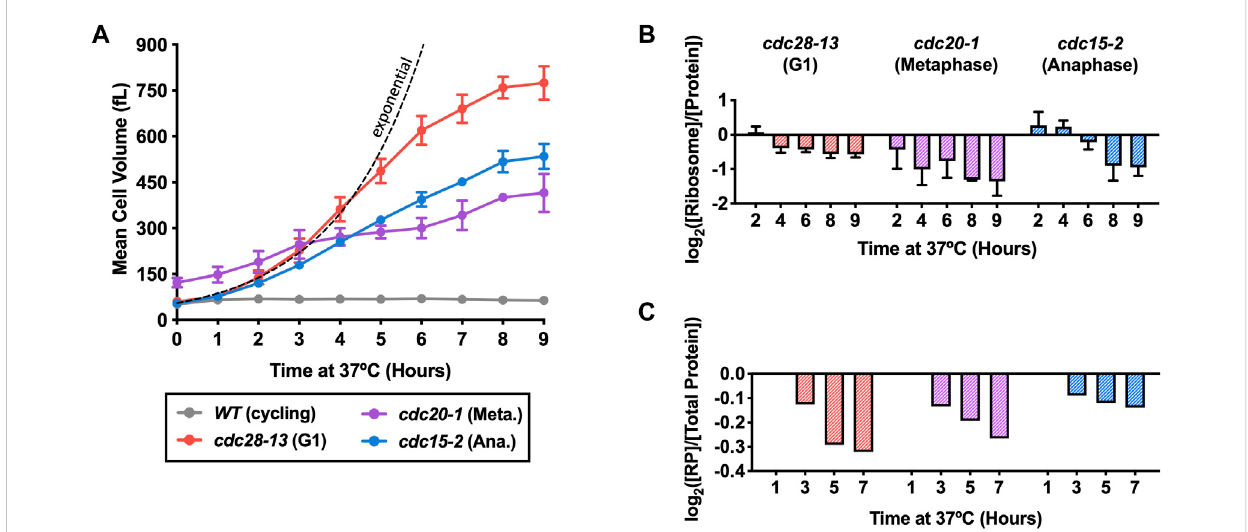
FIGURE 1 Ribosome concentrations decrease during prolonged cell cycle arrest. WT (A2587), cdc28-13 (A39000), cdc20-1 (A937), and cdc15-2 (A2596) cells weregrowntologphaseinYEPDat25 ° Candthenshiftedto37 ° Cfor9 h. WT cultureswerekeptinlogphase(cycling)atOD 600nm 0.2 – 0.8,bydilutingwith pre-warmed (37 ° C) YEPD. (A) Mean cell volume (fL) was measured on a Coulter Counter. Error bars represent standard deviations of ≥ 3 biological replicates and the range of two replicates in cdc20-1 mutants. The dashed black line indicates theoretical perfect exponential volume growth (90- min doubling time). (B) Protein and ribosome concentrations were quanti fi ed using a quantitative ribosome puri fi cation method as described in the method section. Values were normalized to those of the WT cycling samples at each time point and subsequently log 2 transformed. Error bars represent the range of two biological replicates. (C) TMT Proteomics was performed on the cdc-ts strains as described in the methods except for the cdc28-13 arrest,whereourpreviouslypublishedTMTproteomicsdatawereusedtoquantifytheribosomalproteomefraction(Neurohretal.,2019).Thefractionof ribosomal proteins (RP) in total protein extracts ([RP]/[Total Protein]) was determined. Values were normalized to the 1-h time point in each experiment and subsequently